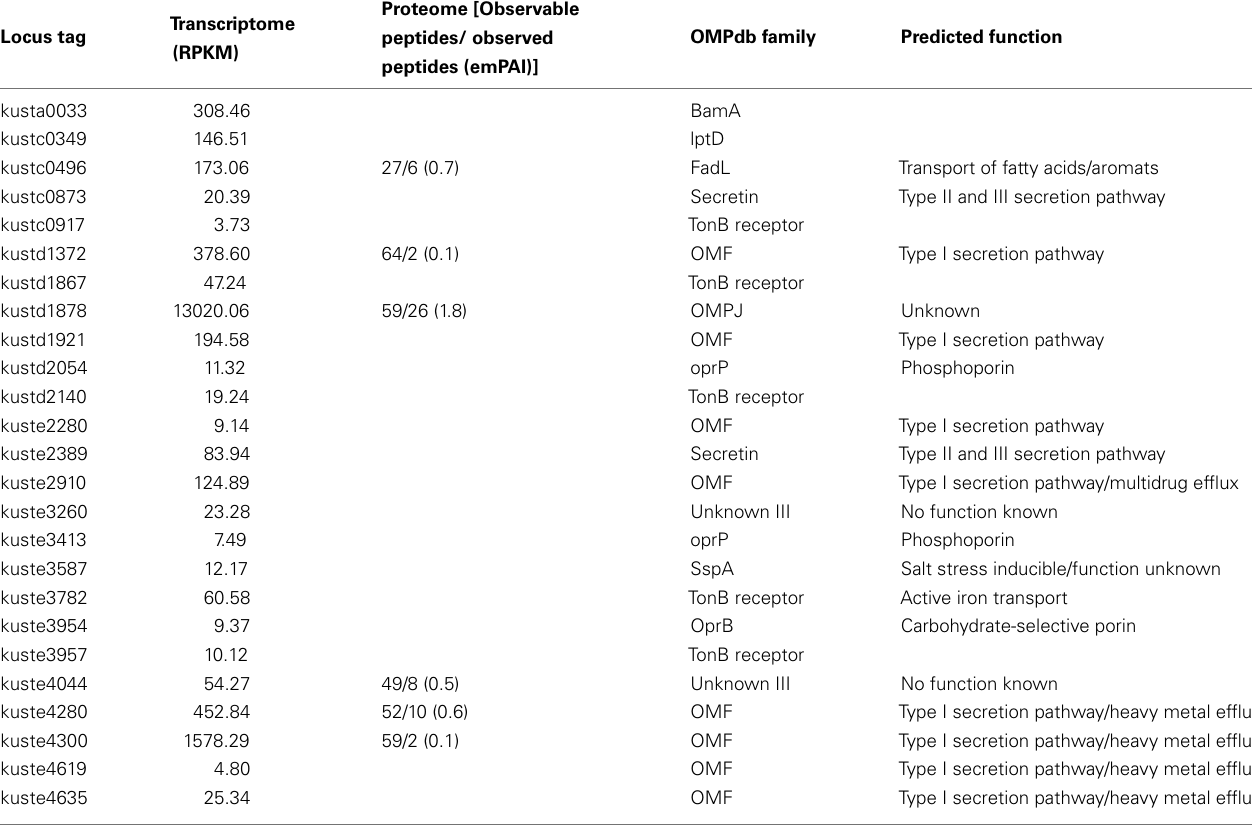
Table 3 | Gene and protein expression of outer membrane proteins in anammox Planctomycete “Candidatus Kuenenia stuttgartiensis.”